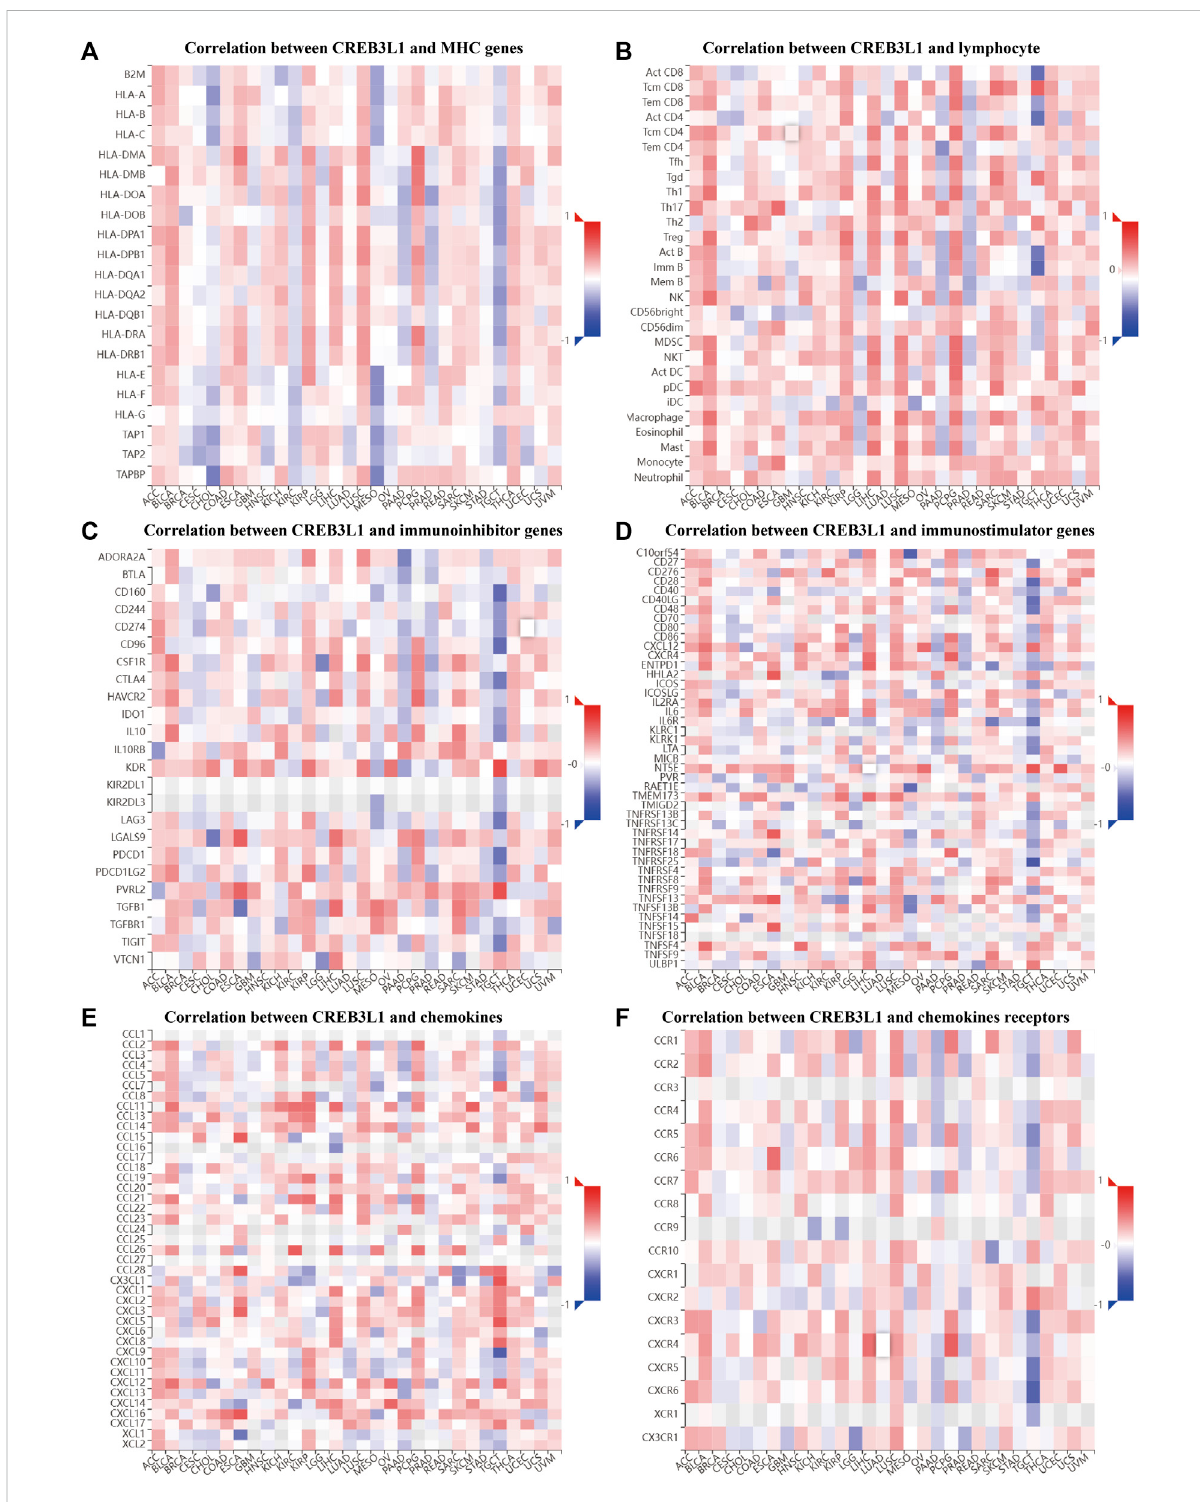
FIGURE 7 The correlation between CREB3L1 expression and immune-related biomarkers in TISIDB database. The co-expression heatmaps show the association between CREB3L1 expression and (A) MHC genes, (B) lymphocyte, (C) immunoinhibitor genes, (D) immunostimulator genes, (E) chemokines, and (F) chemokines receptors in different